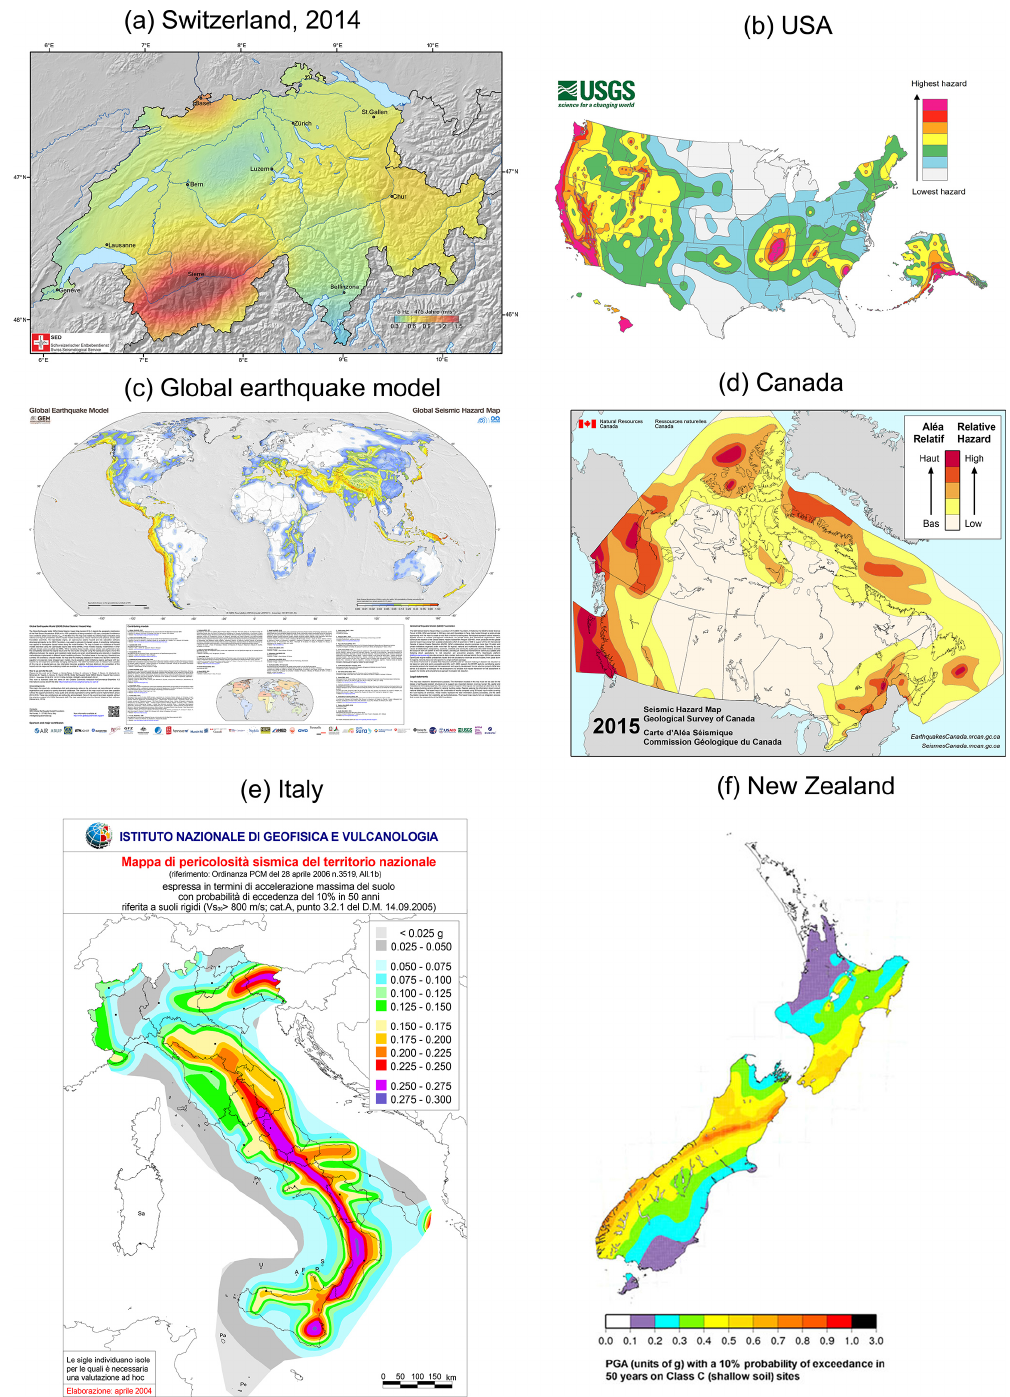
Figure 1. Selection of national seismic hazard maps: (a) Swiss seismic hazard map (Swiss Seismological Service, 2018; http: //www.seismo.ethz.ch/knowledge/seismic-hazard-switzerland/), (b) US seismic hazard map (United States Geological Survey, 2018; https://earthquake.usgs.gov/hazards/hazmaps/), (c) Global Earthquake Model (GEM) Seismic Hazard Map (version 2018.1 – De- cember 2018; Pagani et al., 2018; https://www.globalquakemodel.org/gem, last access: 2 July 2019), (d) simplified seismic haz- ard map for Canada (the provinces and territories; Natural Resources Canada, 2018; http://www.earthquakescanada.ca/hazard-alea/ simphaz-en.php), (e) “pericolosità sismica di riferimento per il territorio nazionale” (Istituto Nazionale di Geofisica e Vul- canologia, 2018; http://zonesismiche.mi.ingv.it/), and (f) the 2010 National Seismic Hazard Model for New Zealand (Institute of Geological and Nuclear Sciences Limited, 2018; https://www.gns.cri.nz/Home/Our-Science/Natural-Hazards-and-Risks/Earthquakes/